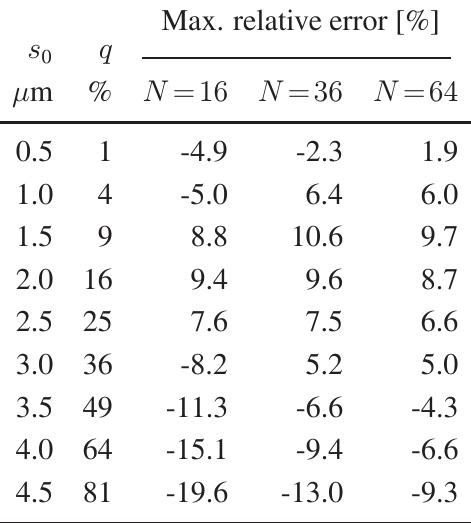
simulated with m = 0 . 5 µ m . . . 5 µ m. c